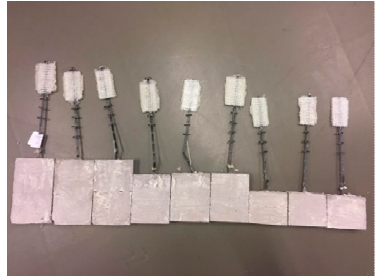
Figure 12. The specimens after pull-out tests.